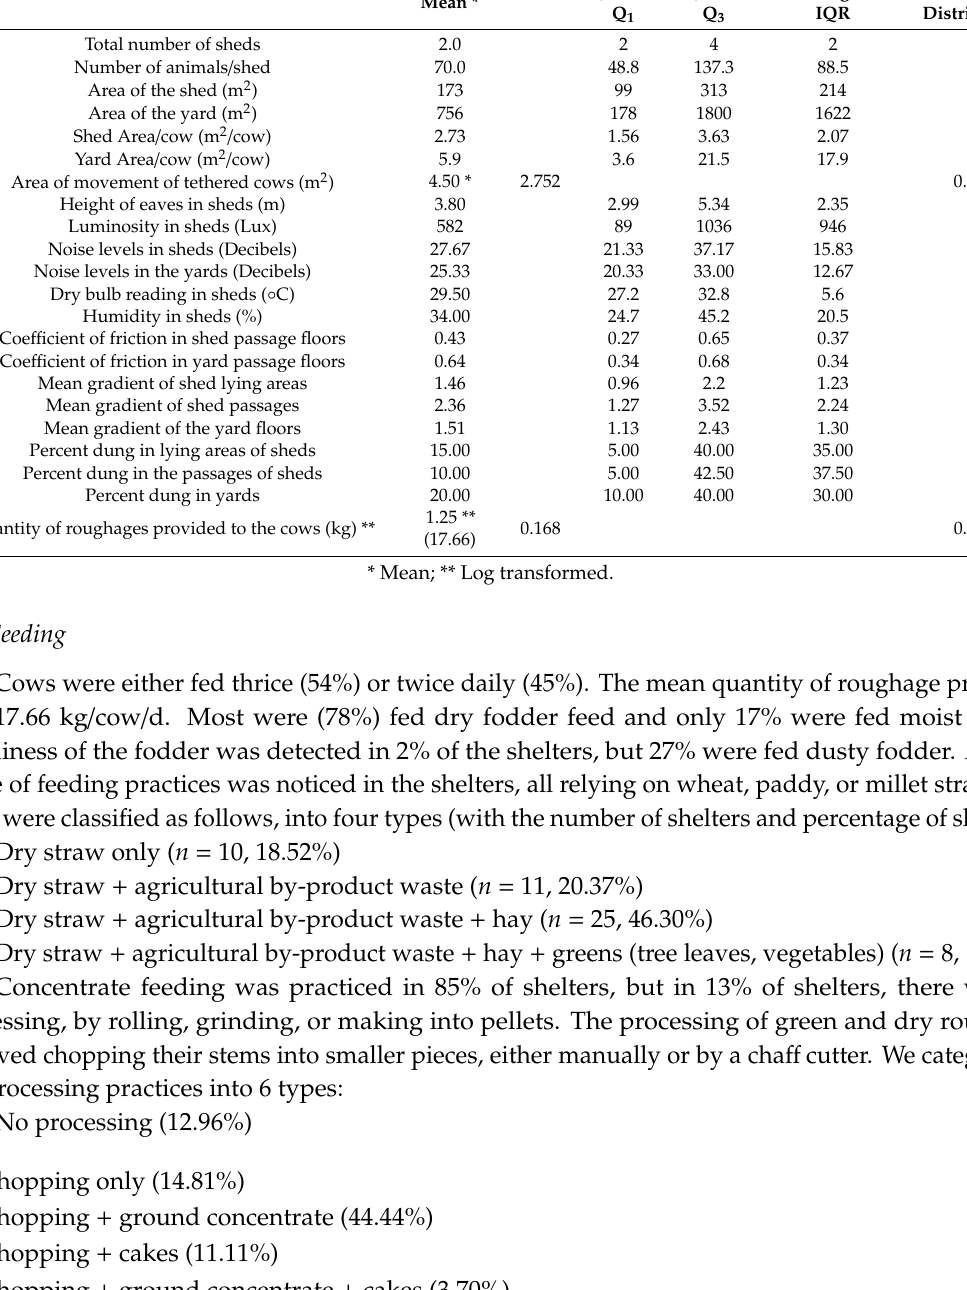
Table 2. Median, first quartile (Q 1 ), third quartile (Q 3 ), and interquartile range (IQR) values for the non-normally distributed data, and mean, standard deviation (SD), and p -values for the normally distributed data, for resource-based parameters of cows in shelters. Variable Total number of sheds 2.0 2 4 2 Number of animals / shed